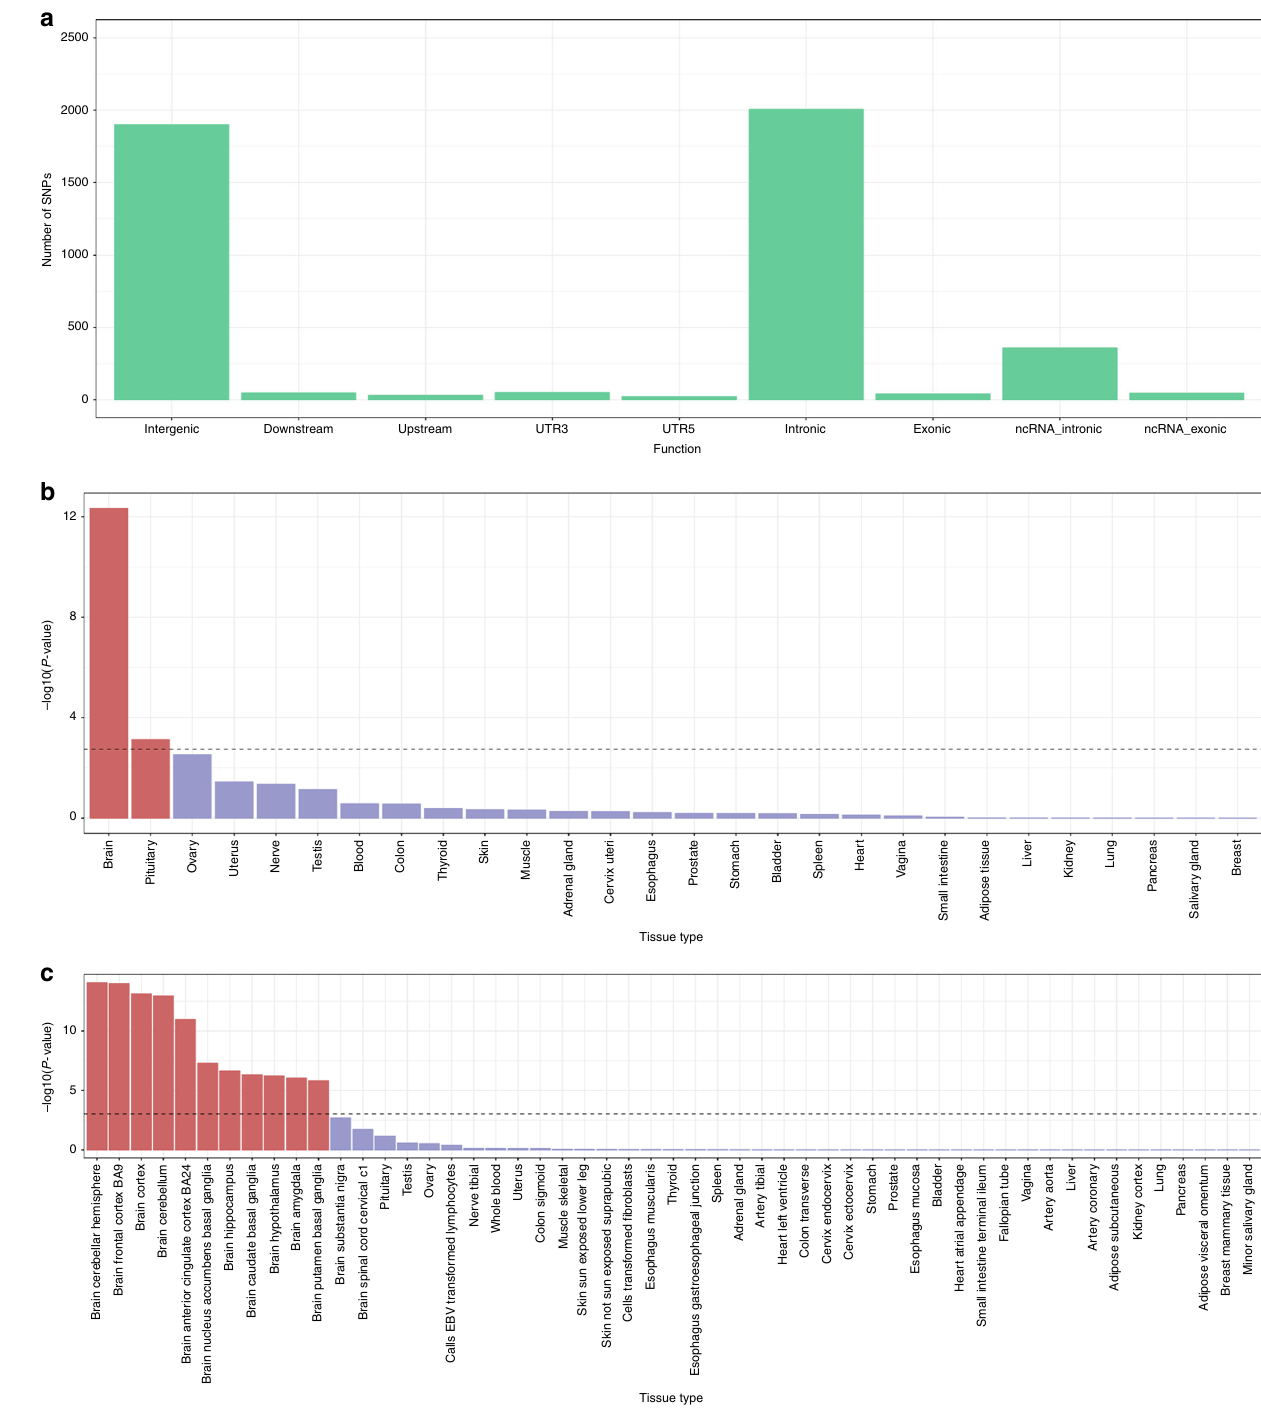
Reaction time results . GWAS results for mean reaction time uncovered 2022 signi fi cant SNPs in 42 independent genomic loci (Fig. 4a; Supplementary Fig. 2c; Supplementary Data 10). Sug- gestive fi ndings are presented in Supplementary Data 11. Both of the signi fi cant loci previously reported for this phenotype were